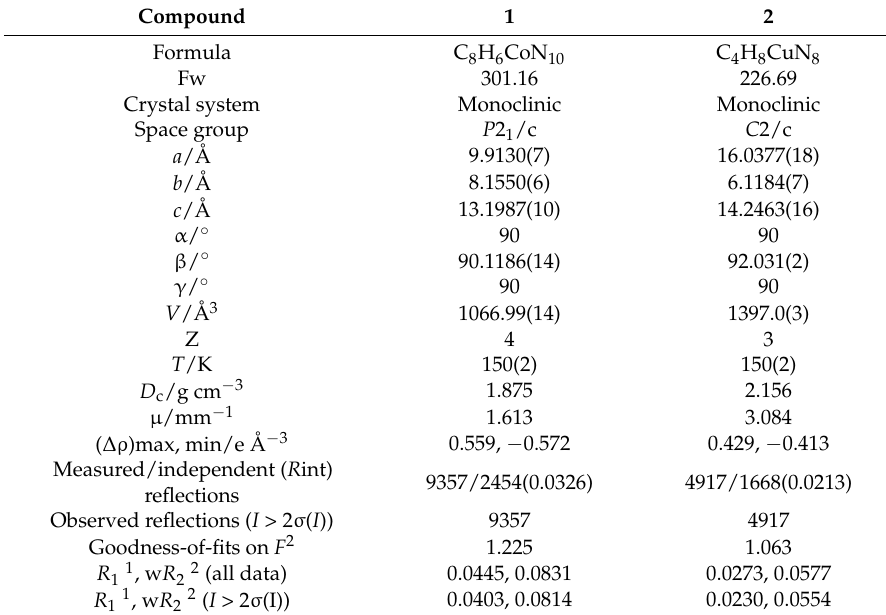
Table 1. Crystallographic data for 1 and 2